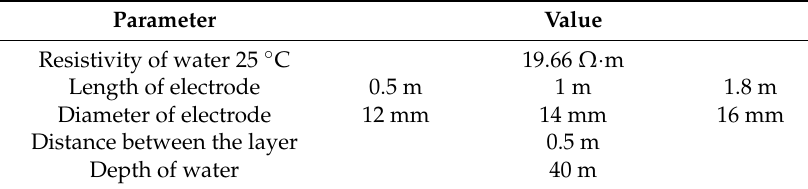
Table 1. Simulation parameters for the grounding resistance.